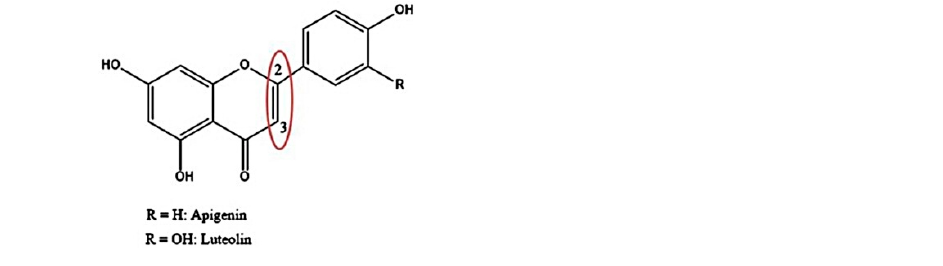
Figure 10. Chemical structure of glucosidic flavonoids (luteolin and apigenin).